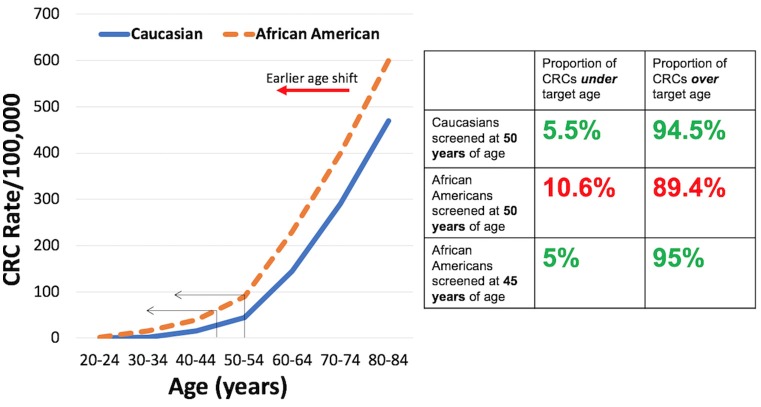
(Left) Rates per 100,000 of colorectal cancer for Caucasians and African Americans by age group. (Right) Proportion of colorectal cancers under and over targeted ages for screening for Caucasians and African Americans.